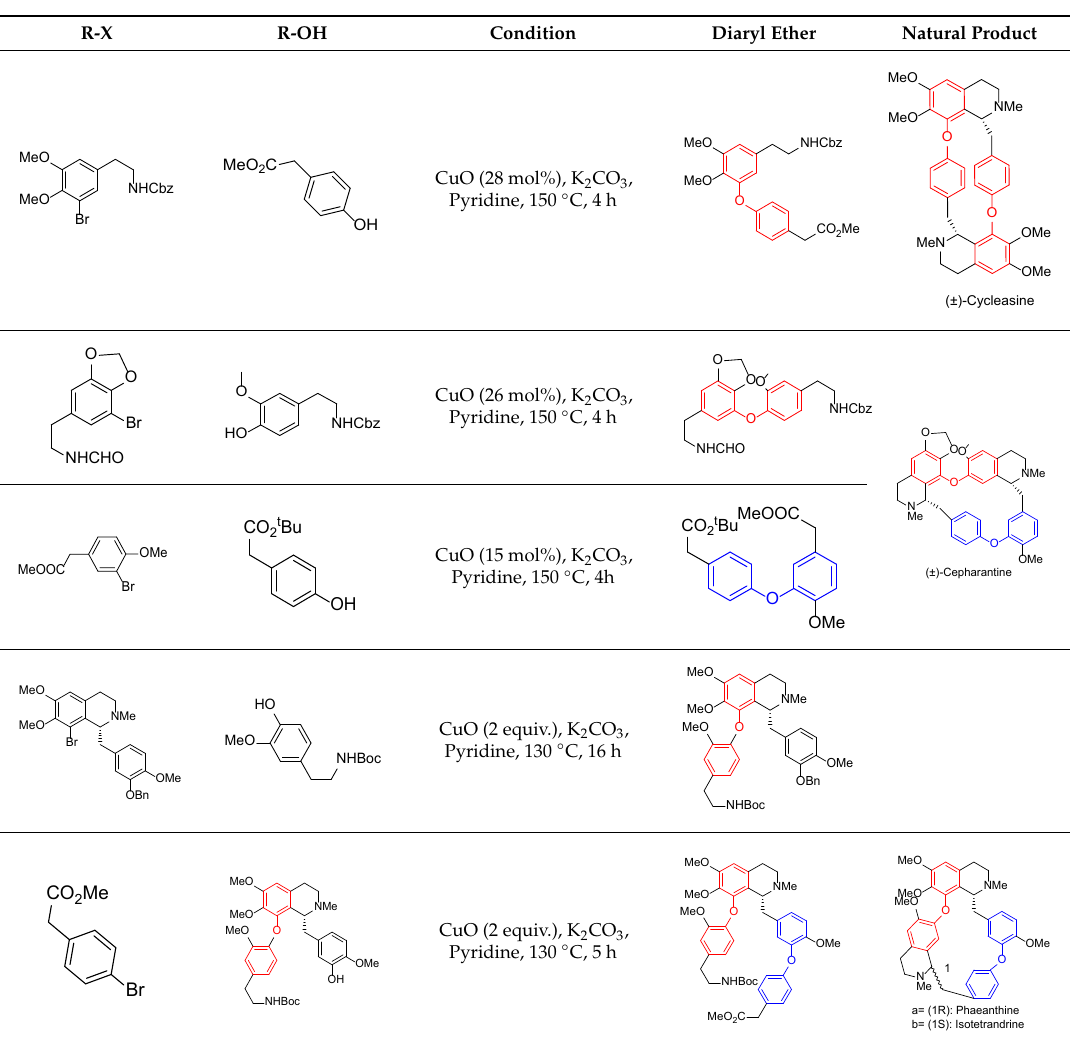
Table 9. The complete synthesis of various natural product compound.